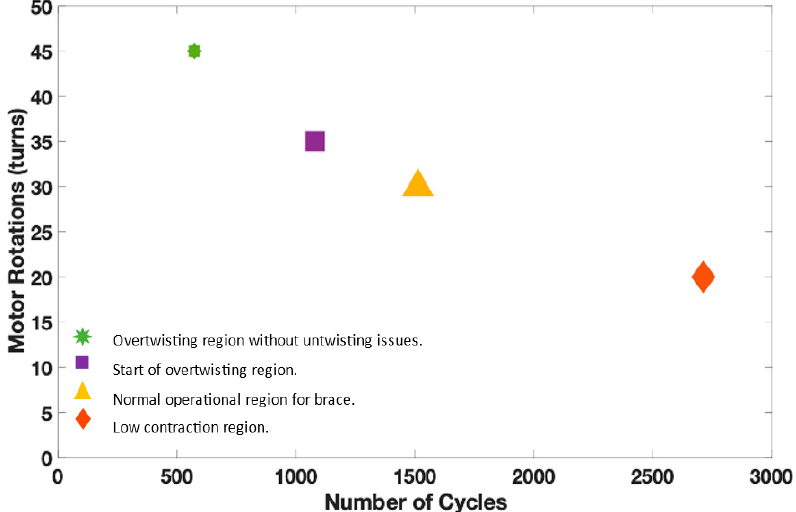
Figure 7. Lifecycle test of twisted strings with different twisting regions.